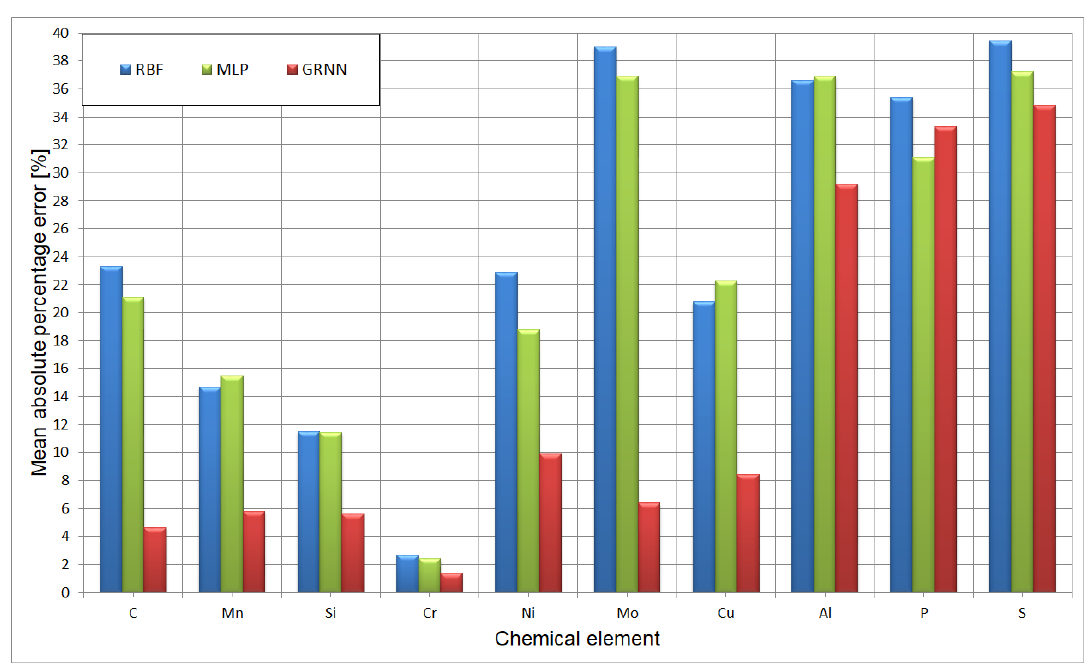
Figure 3. Comparison of mean absolute percentage error for the best achieved artificial neural networks (testing set), build for examinate steels.